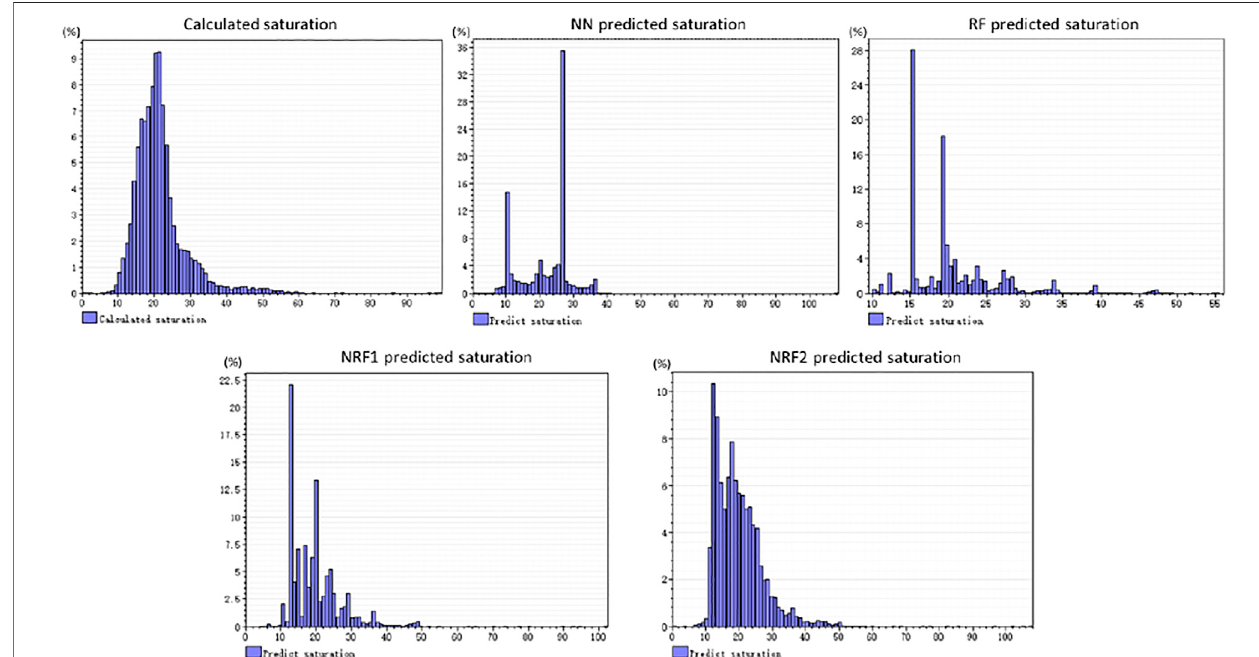
FIGURE 10 | Histogram of saturation data distribution.